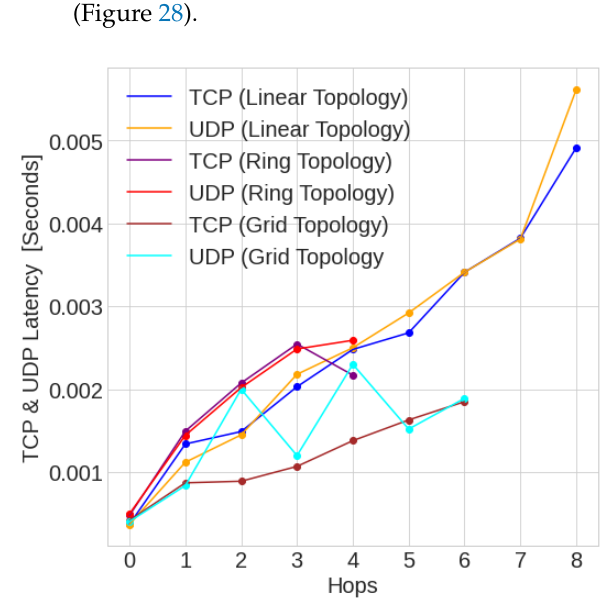
Figure 28. W-iLab2.t TCP and UDP